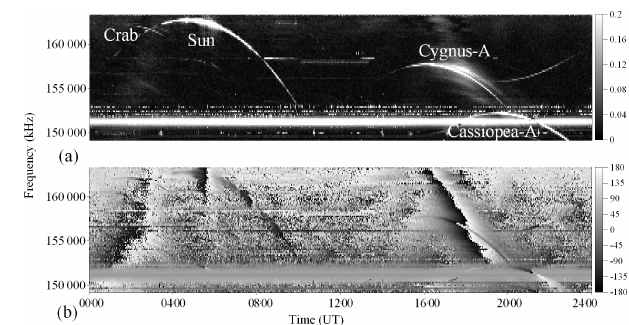
Figure 13. Variation of space noise during a 24h period; (a) mod- ulus and (b) phase of the correlation